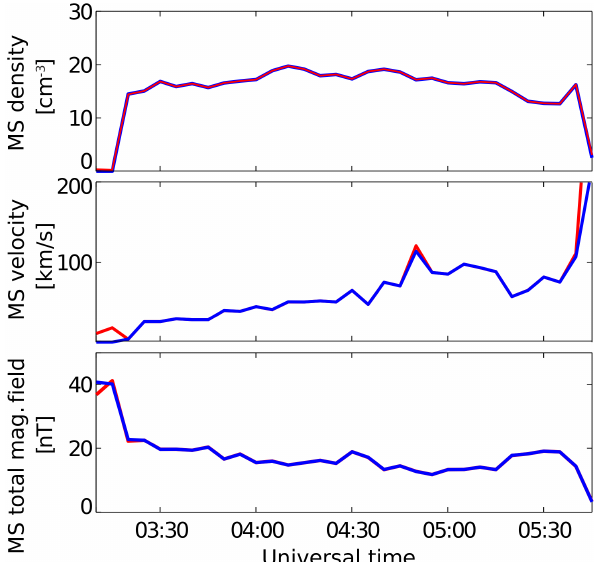
Figure 4. The reconstructed solar wind boundary conditions of the model density (top panel), the ion velocity (middle panel), and the magnetic field (bottom panel) for the magnetosheath data presented in Fig. 3 are shown in blue. Additionally, the THB (red) and OMNI (green) solar wind data during this time interval is